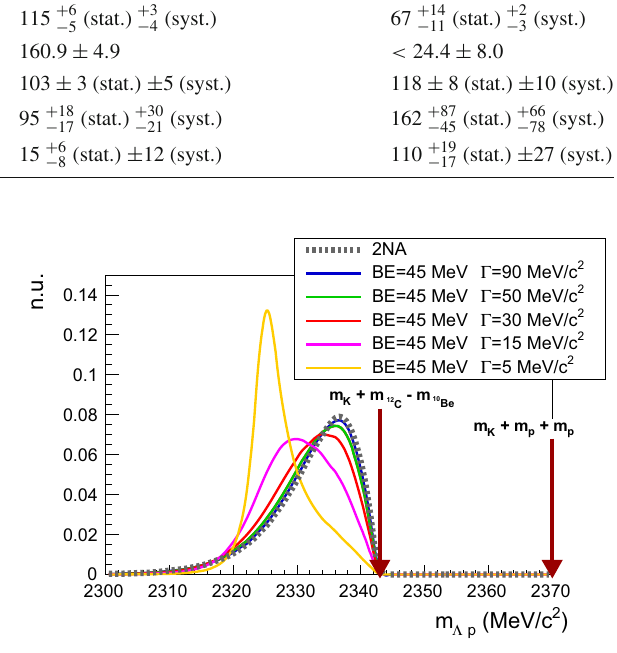
Fig. 7 Calculated (cid:2) p invariant mass distributions for the process K − + 12 C → K − pp + 10 Be → (cid:2) + p + 10 Be, for a bound state hav- ing BE = 45 MeV and (cid:14) = 5, 15, 30, 50 and 90 MeV / c 2 (yellow, magenta, red, green and blue curves respectively). The gray curve is the shape of the 2NA-QF. The areas of the distributions are normalised to